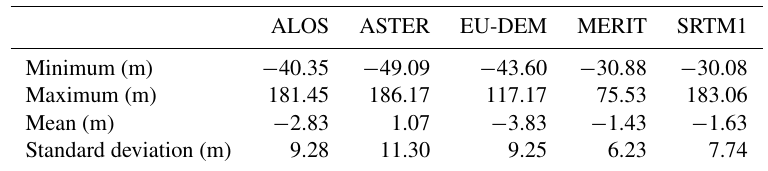
Table C4. Statistical results of test calculations of consistency of station heights for the territory of Slovakia (7097 points) and global DEMs tested.